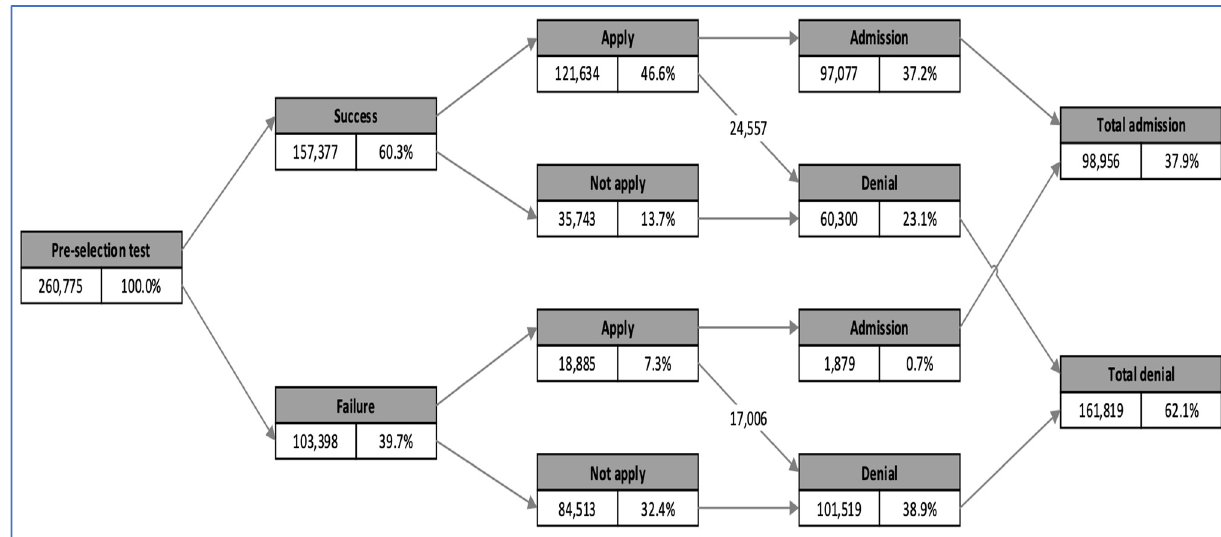
Figure 1. Trajectory data distribution.